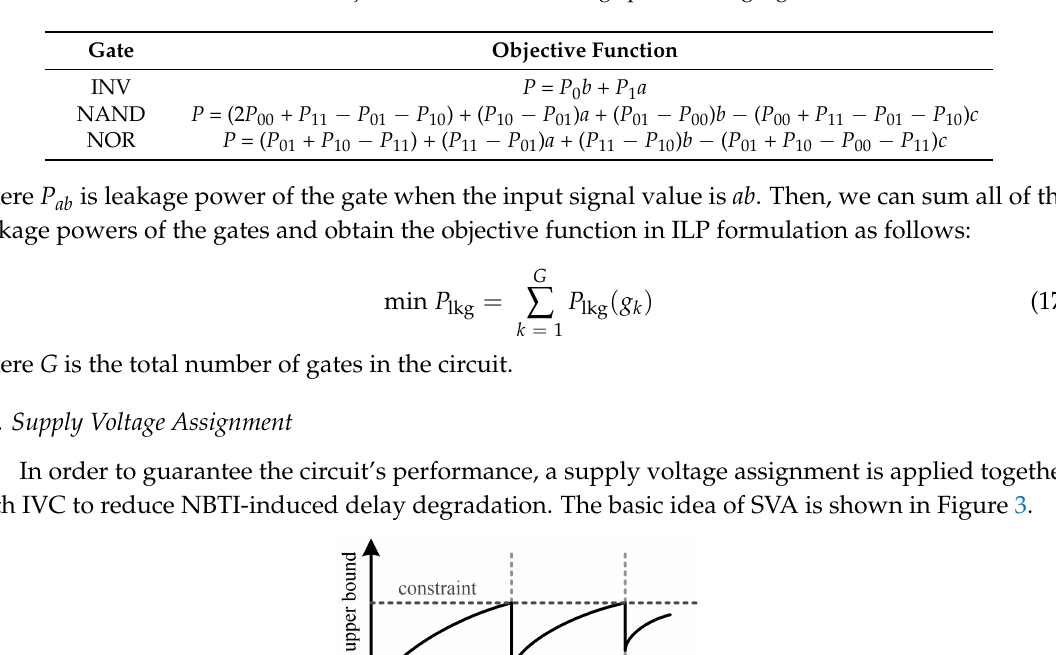
Table 3. ILP objective function for leakage power of logic gates.